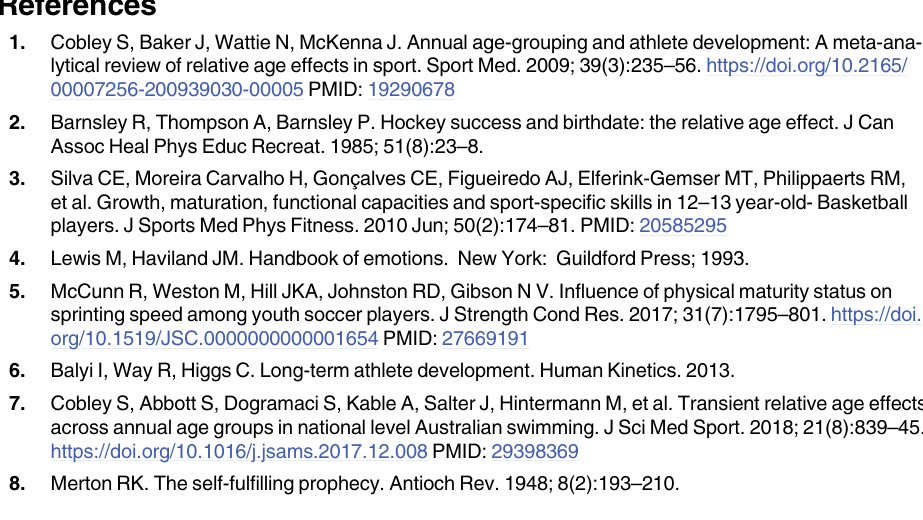
S1 Table. Summary of country representation within the